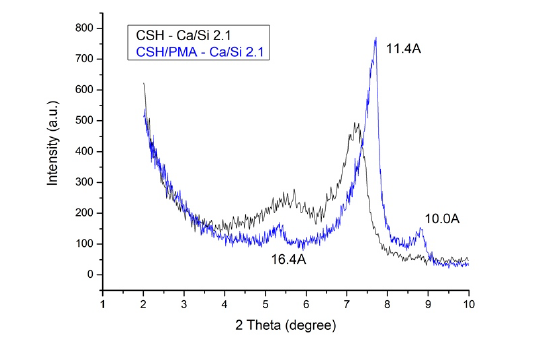
Figure 1. XRD spectra of C-S-H and C-S-H/PMA.